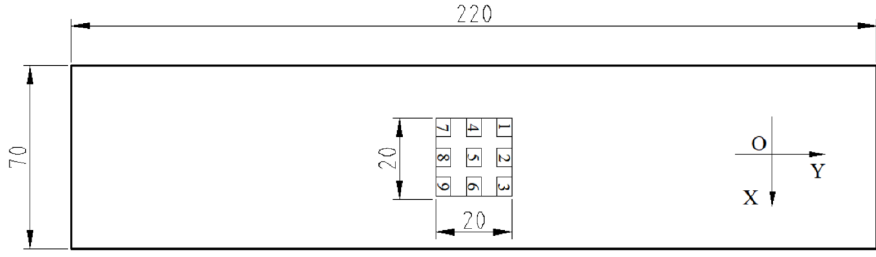
Figure 1. Dimensions of a specimen (in mm) and measuring area.